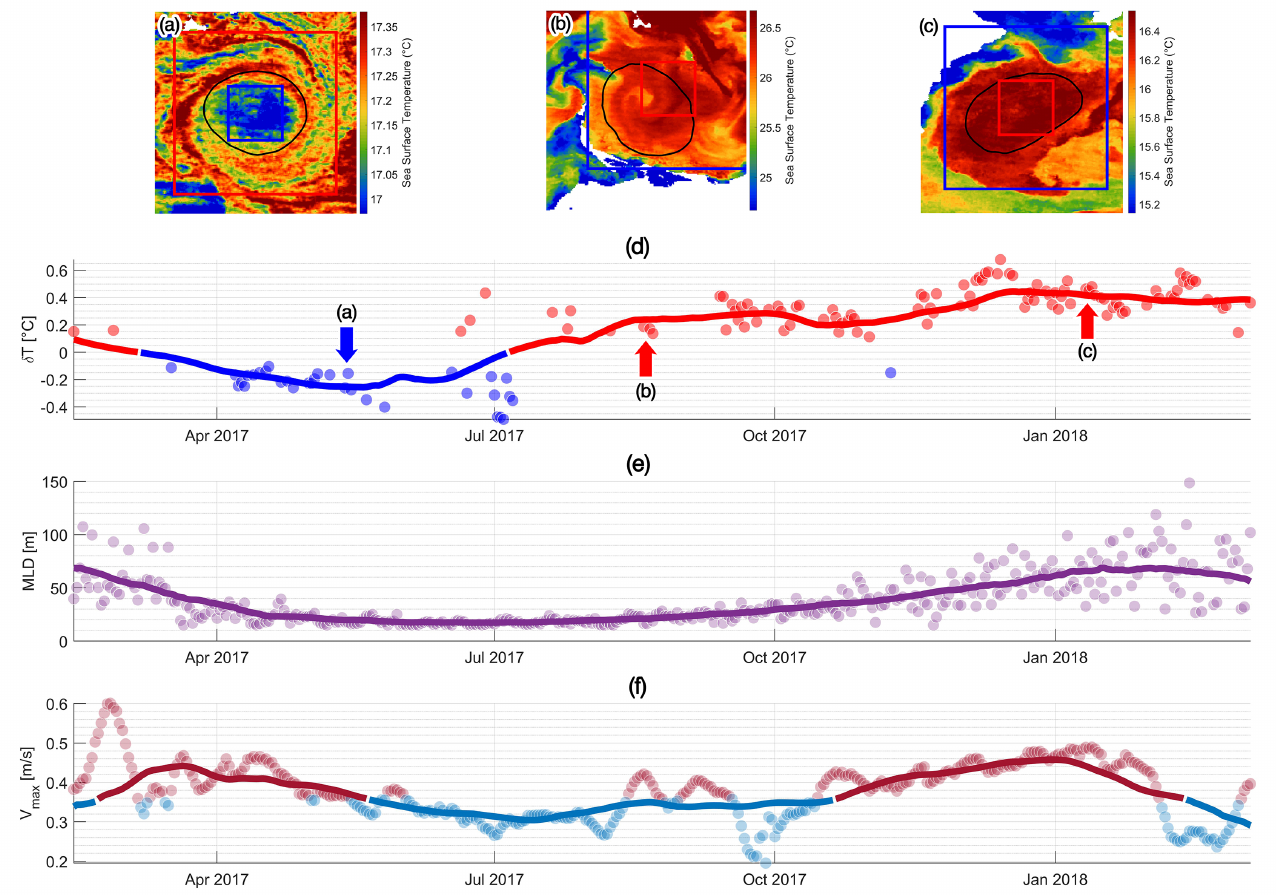
Figure A1. Timeline of the Algeria anticyclone with DYNED ID #11411. Panels ( a – c ) show four characteristic SST patches corresponding with the δ T evolution in panel ( d ). Panel ( e ) shows the evolution of the MLD outside the eddy. Panel ( f ) shows the evolution of the maximal velocity. Lines represent the Monthly Mean Average of each variable. For more information, the reader is referred to Figure